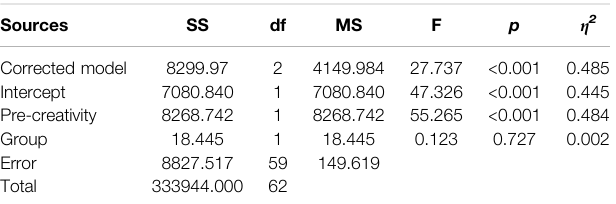
TABLE 4 | The ANCOVA analysis to compare different group students ’ scienti fi c creativity ( n (cid:1) 62). Sources SS df MS F p η 2 Corrected